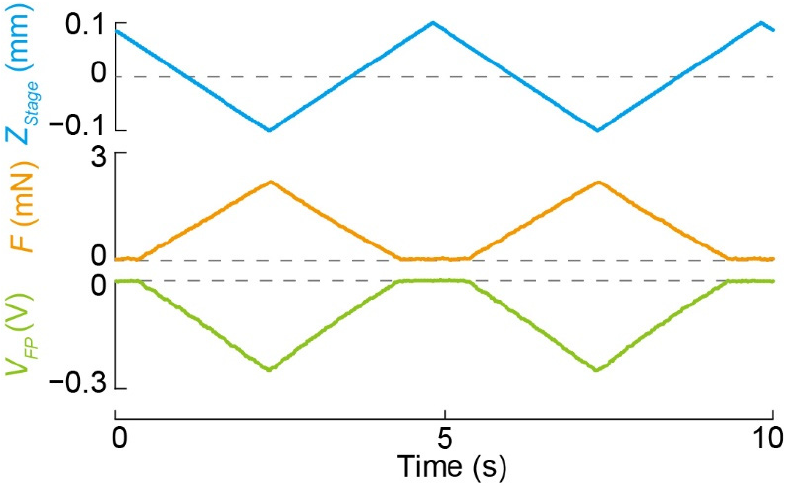
Figure 10. Measured Z stage , F , and V FP when the needle was pushing at the center.